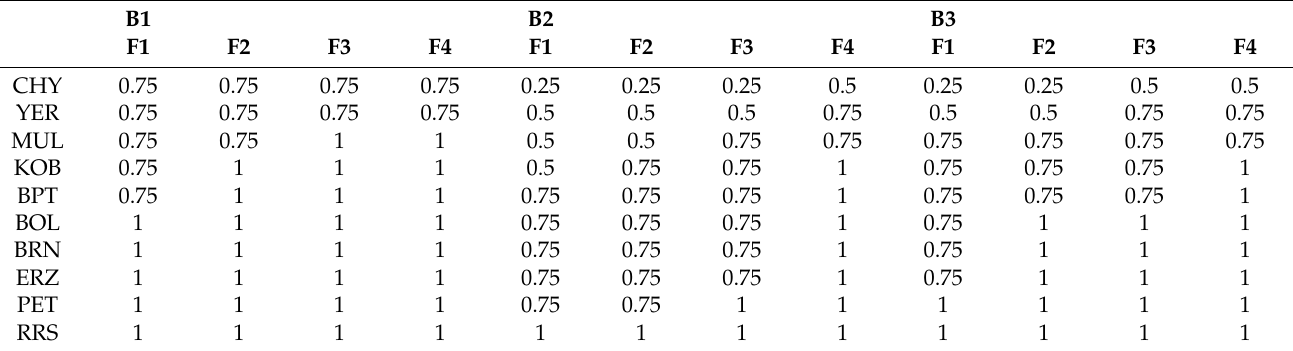
Table 7. Losses (L).